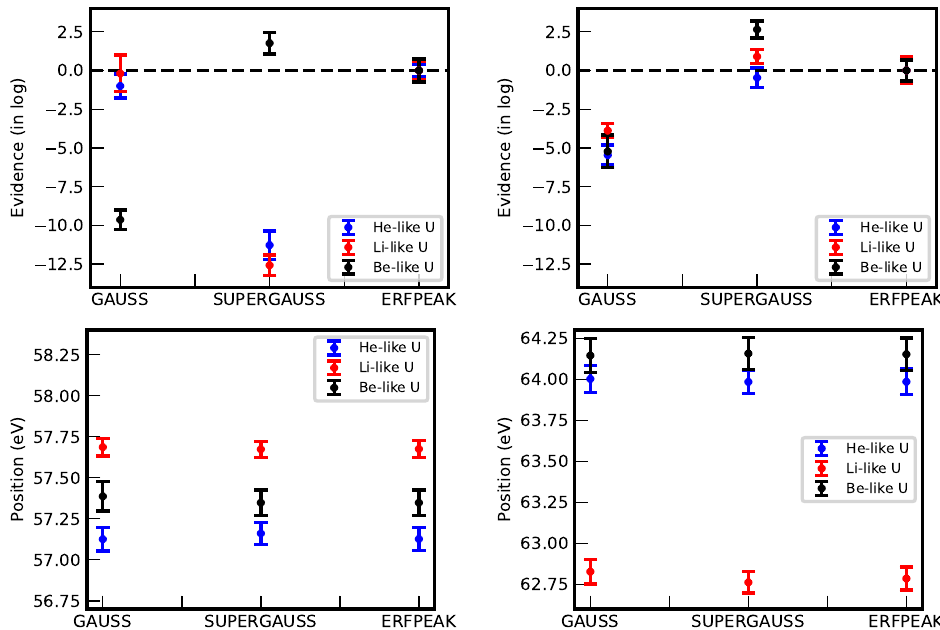
Figure 2. Plot of the relative evidence values ( top ) and spectral line position ( bottom ) for different line models for the spectra obtained by the inner ( left ) and outer ( right )